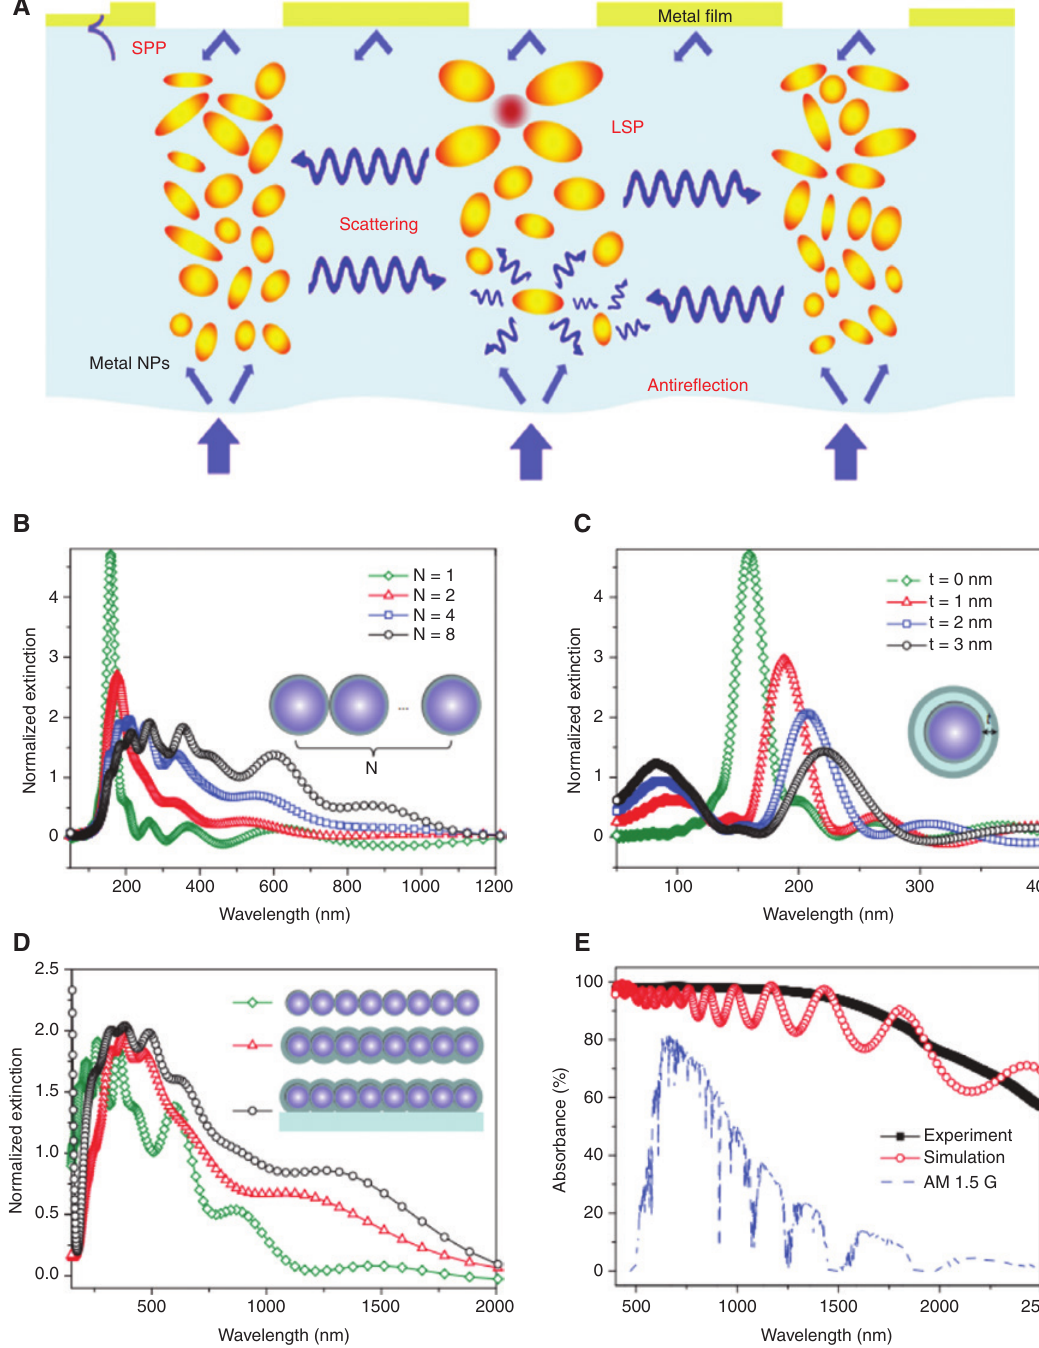
Figure 4: (A) Schematic of hybridized plasmonic structure to enhance solar absorption [60]; dependence of calculated normalized extinction cross-section of Al nanoparticles on (B) the particle number N, (C) on the thickness of the alumina oxidation layer t, and (D) on the substrate; and (E) experimental and simulated absorption of aluminum-based plasmonic absorbers. The normalized spectral solar irradiance density of air mass 1.5 global (AM 1.5 G) tilt solar spectrum is shown by the blue dashed line [85]. (A) Adapted by permission